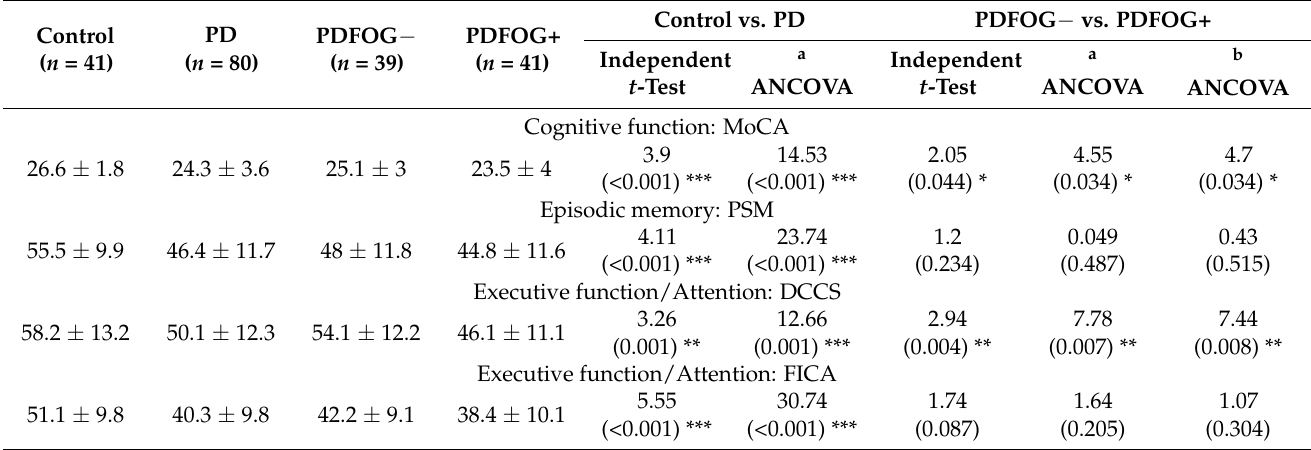
Figure 1. Violin plots display the cognitive measurements in healthy controls, PDFOG−, and PDFOG+. ( A ) Montreal cognitive assessment (MoCA); ( B ) picture sequence memory (PSM) test; ( C ) dimensional change card sort (DCCS) test; ( D ) flanker inhibitory control and attention (FICA) test; ( E ) picture vocabulary (PV) test; ( F ) pattern comparison processing speed (PCPS) test; ( G ) Response Time Coefficient of Variation of 7-s interval timing task (RTCV). The horizontal lines and white circles in the violin plots represent the mean and median values, respectively. Table 2. Cognitive measurements in controls vs. patients with PD.